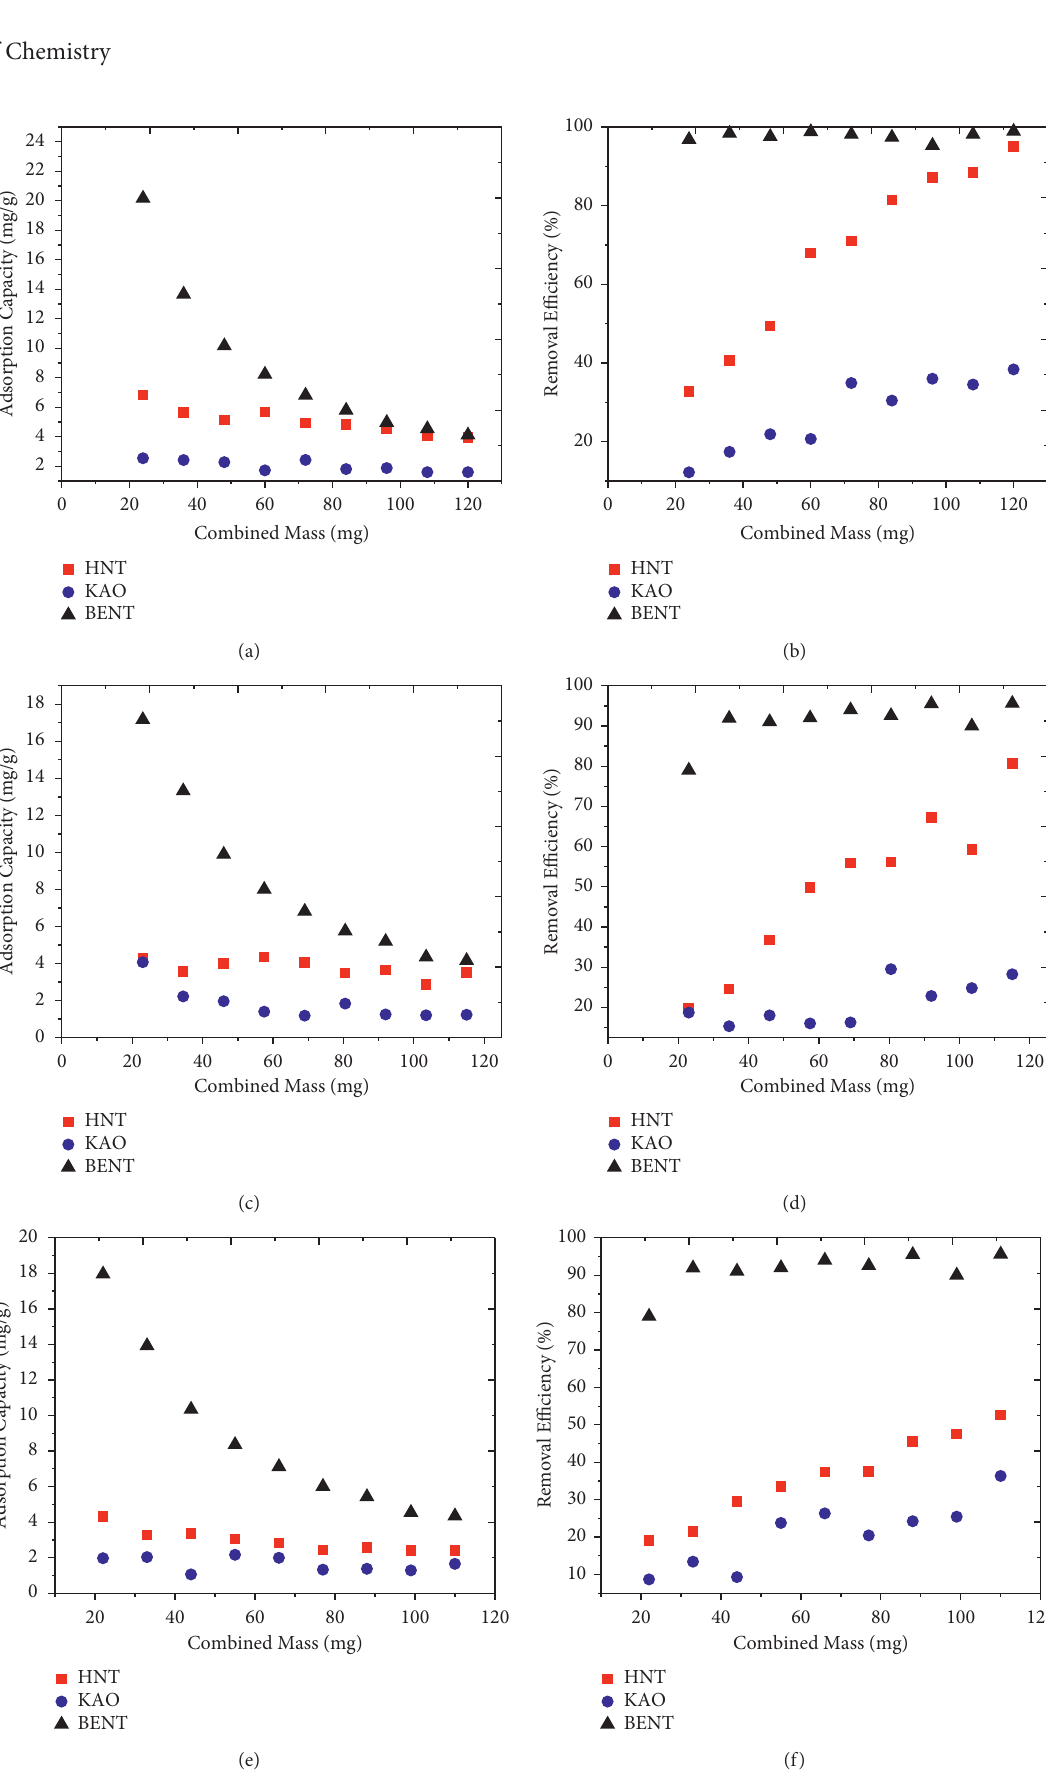
Figure 5: Effect of adsorbent dosage on adsorption capacity and removal efficiency: (a) and (b) for 20% HAP � Clay mass, (c) and (d) for 15% HAP � Clay mass, and (e) and (f) for 10% HAP � Clay